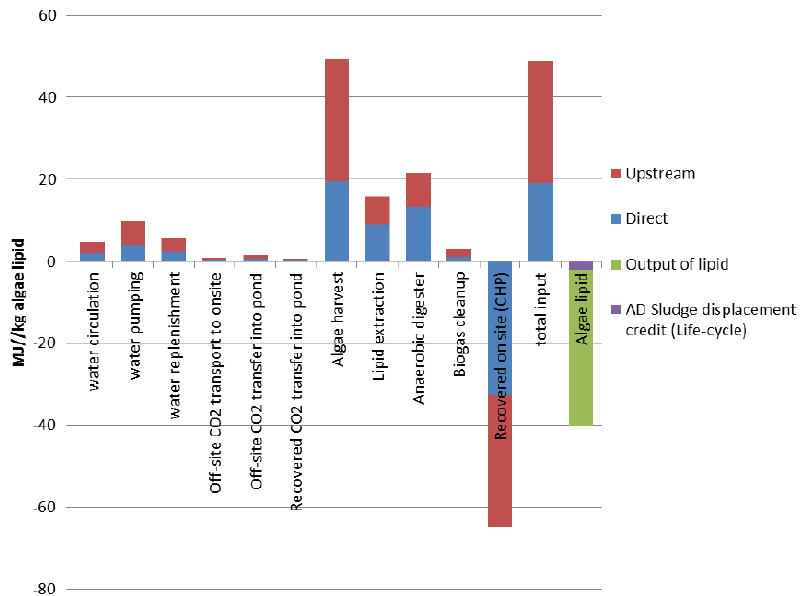
Figure 6. Energy flows from algae cultivation to oil production with recycle